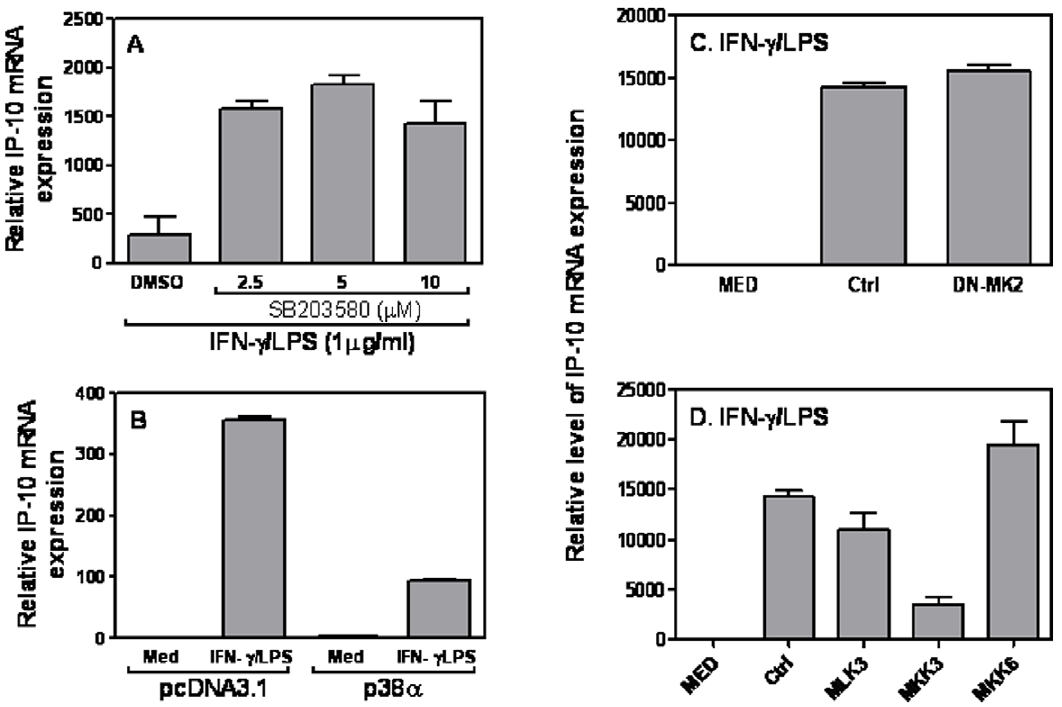
Figure 6. The role of p38 MAPK in IP-10 expression. (A) 1 6 10 6 A7r5 cells were treated with different amounts of a p38 MAPK antagonist SB203580 for 1 h prior to addition of various stimuli as indicated. An identical amount of dissolvent DMSO was used for negative controls. 6 hrs later, total RNA was extracted for measurement of IP-10 mRNA expression by qRT-PCR. 5 m g of different expression plasmids encoding different molecules involved in the p38 MAPK signaling pathway including p38 a (B), and DN-MK2 (C), as well as MLK3, MKK3, and MKK6 (D) or empty vector were transiently transfected with Lipofectamine. 48 h after transfection, the cells were treated with LPS (1 m g/ml) plus IFN- c (10 ng/ml) for 6 h, followed by measurement of IP-10 mRNA expression by qRT-PCR. qRT-PCR data were normalized relative to GAPDH mRNA expression levels in each respective sample and further normalized to the results from the un-treated group, which was set as 1. Results shown are mean plus SD of three independent